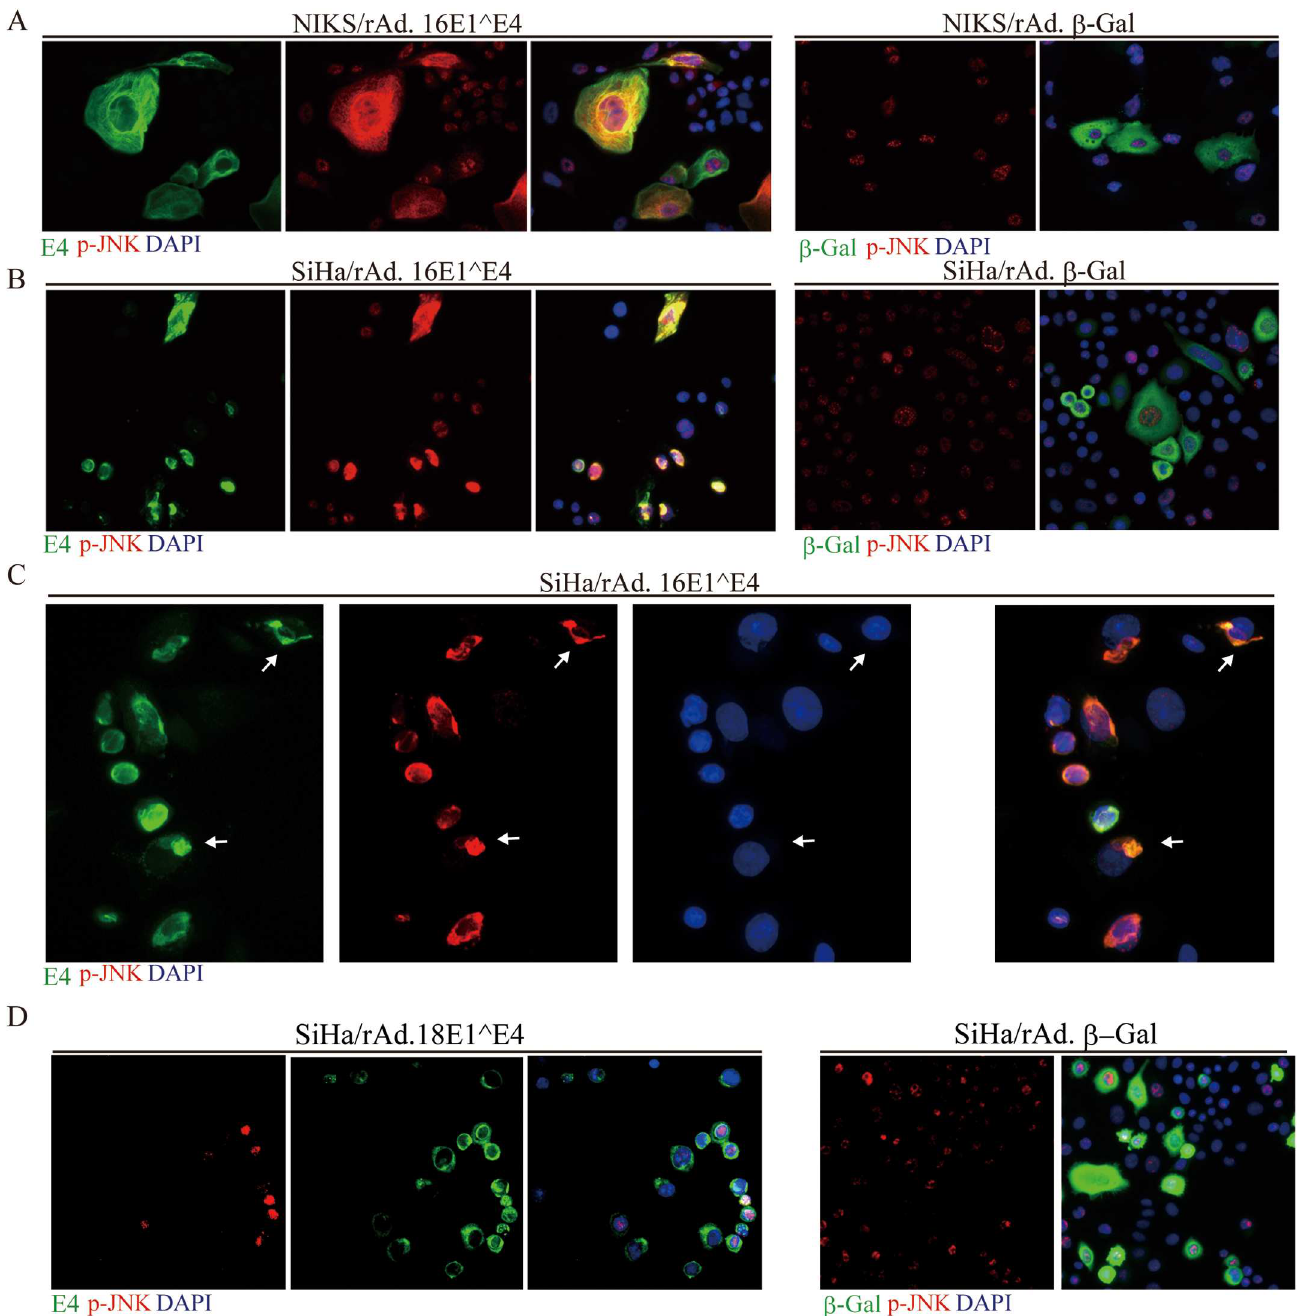
Fig 7. 16E1^E4expression sustains JNK activation and cytoplasmic sequestration. (A) NIKS cells were infected for 48 hours with rAd.16E1^E4 or rAd. β -Gal as a negativecontrol. The cells were stainedfor 16E1^E4(green) or β -Gal, p-JNK (red) and DNA (blue; DAPI). As seen in vivo , 16E1^E4 expressionis associated with a dramatic elevationin cytoplasmic p-JNK staining. (B & C) SiHa cells were infected for 48 hours with rAd.16E1^E4 or rAd. β -Gal (negativecontrol), before being stained for 16E1^E4or β -Gal (green), along with p-JNK (red) and DNA (blue; DAPI). In SiHa cells, the p-JNK stainingis associatedwith the perinuclearcollapsedE1^E4 keratin networkswhich can be visualisedmore clearly in the enlargedimage shownin (C). PerinuclearE4/Keratin bundlesare arrowed. (D) SiHa cells were infected for 48 hours with rAd.18E1^E4 as describedabove. Cytoplasmic p-JNK staining(red) was not observed. Cells were co-stainedfor the 18E1^E4protein (green)and DAPI (blue).